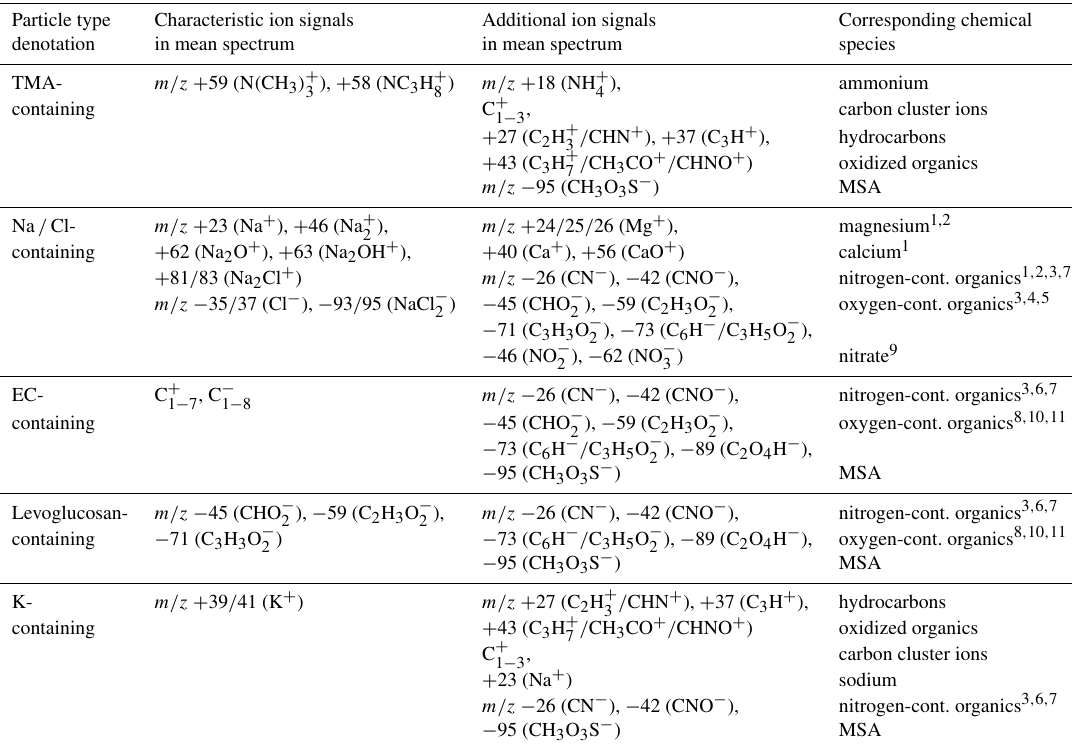
Figure 3. Vertically resolved median (black line) and interquartile ranges (gray shaded area) of the equivalent potential temperature ( (cid:50) e ), relative humidity (RH), wind speed, particle number concentration measured by the UCPC ( N d > 5 nm ) and Sky-OPC ( N d > 250 nm ) as well as the CO mixing ratio (including all conducted flights from 4–12 July 2014). Measurements of N d > 250 nm started on 8 July due to prior technical issues. The red line depicts the derived mean upper height of the boundary layer during this measurement period (approximately 340m). Table 2. Overview of the obtained five particle types and their internal mixing state derived from the mean spectra in Figs. 4 and 7. Additional ion signals of sulfate ( m/z − 97 / 99 (HSO − ), − 96 (SO − )) and potassium ( m/z + 39 / 41 (K + )) were present in every mean spectrum and 4 4 have therefore not been listed here. Further given are references (SPMS lab and field studies) used for the assignment of the additional ion signals to the corresponding chemical